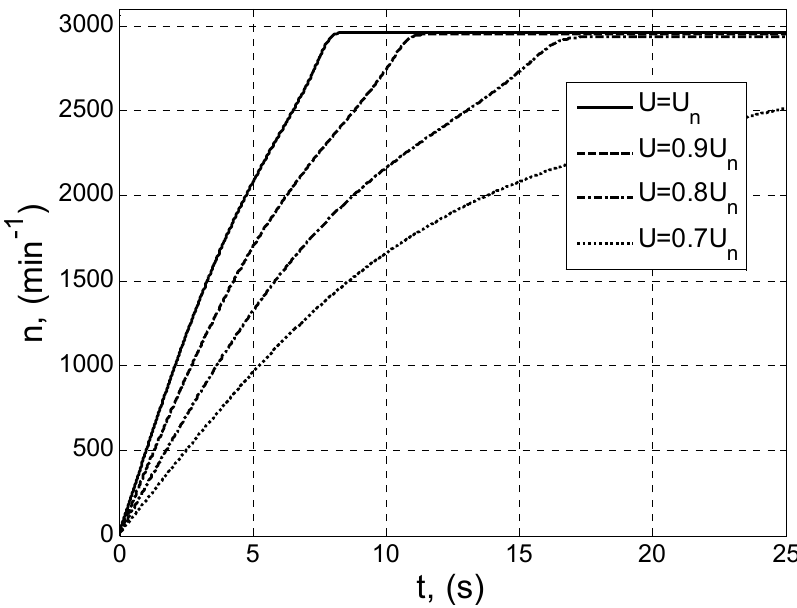
Figure 4. Course of rotational motor speed while powered by different power network voltages in the range between 0.7 ⋅ U n and U n.